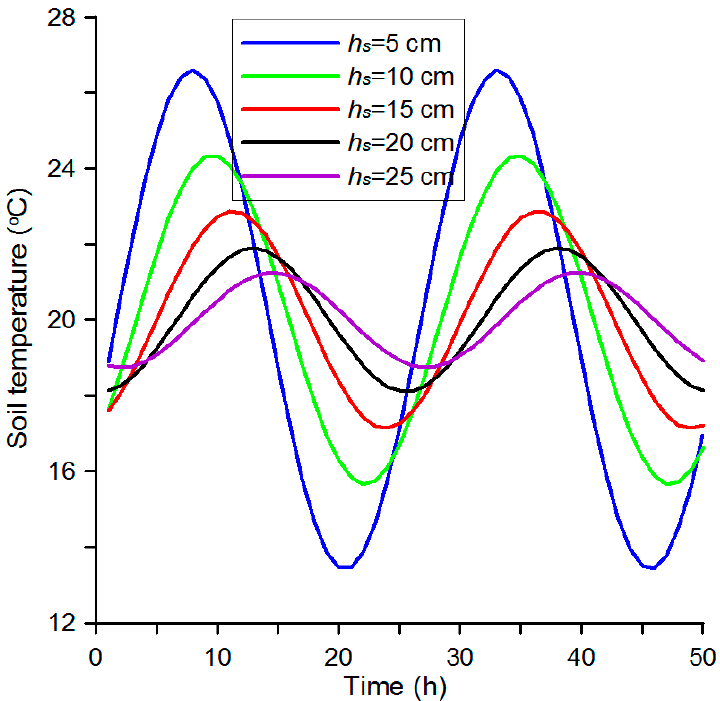
Figure 4. Dynamics of soil temperature variation at different depths according to Equation (1).